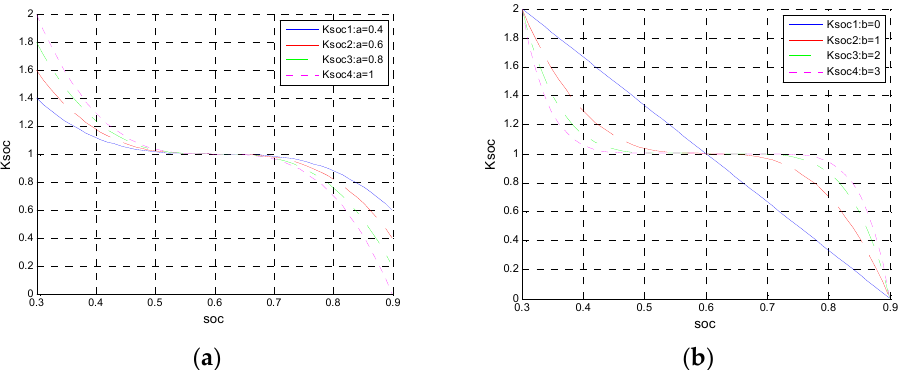
Figure 4. ( a ) The influence of the proportional coefficient on the penalty function; ( b ) the influence of order coefficient on the penalty function.